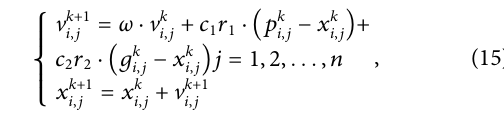
Frontiers in Energy Research |